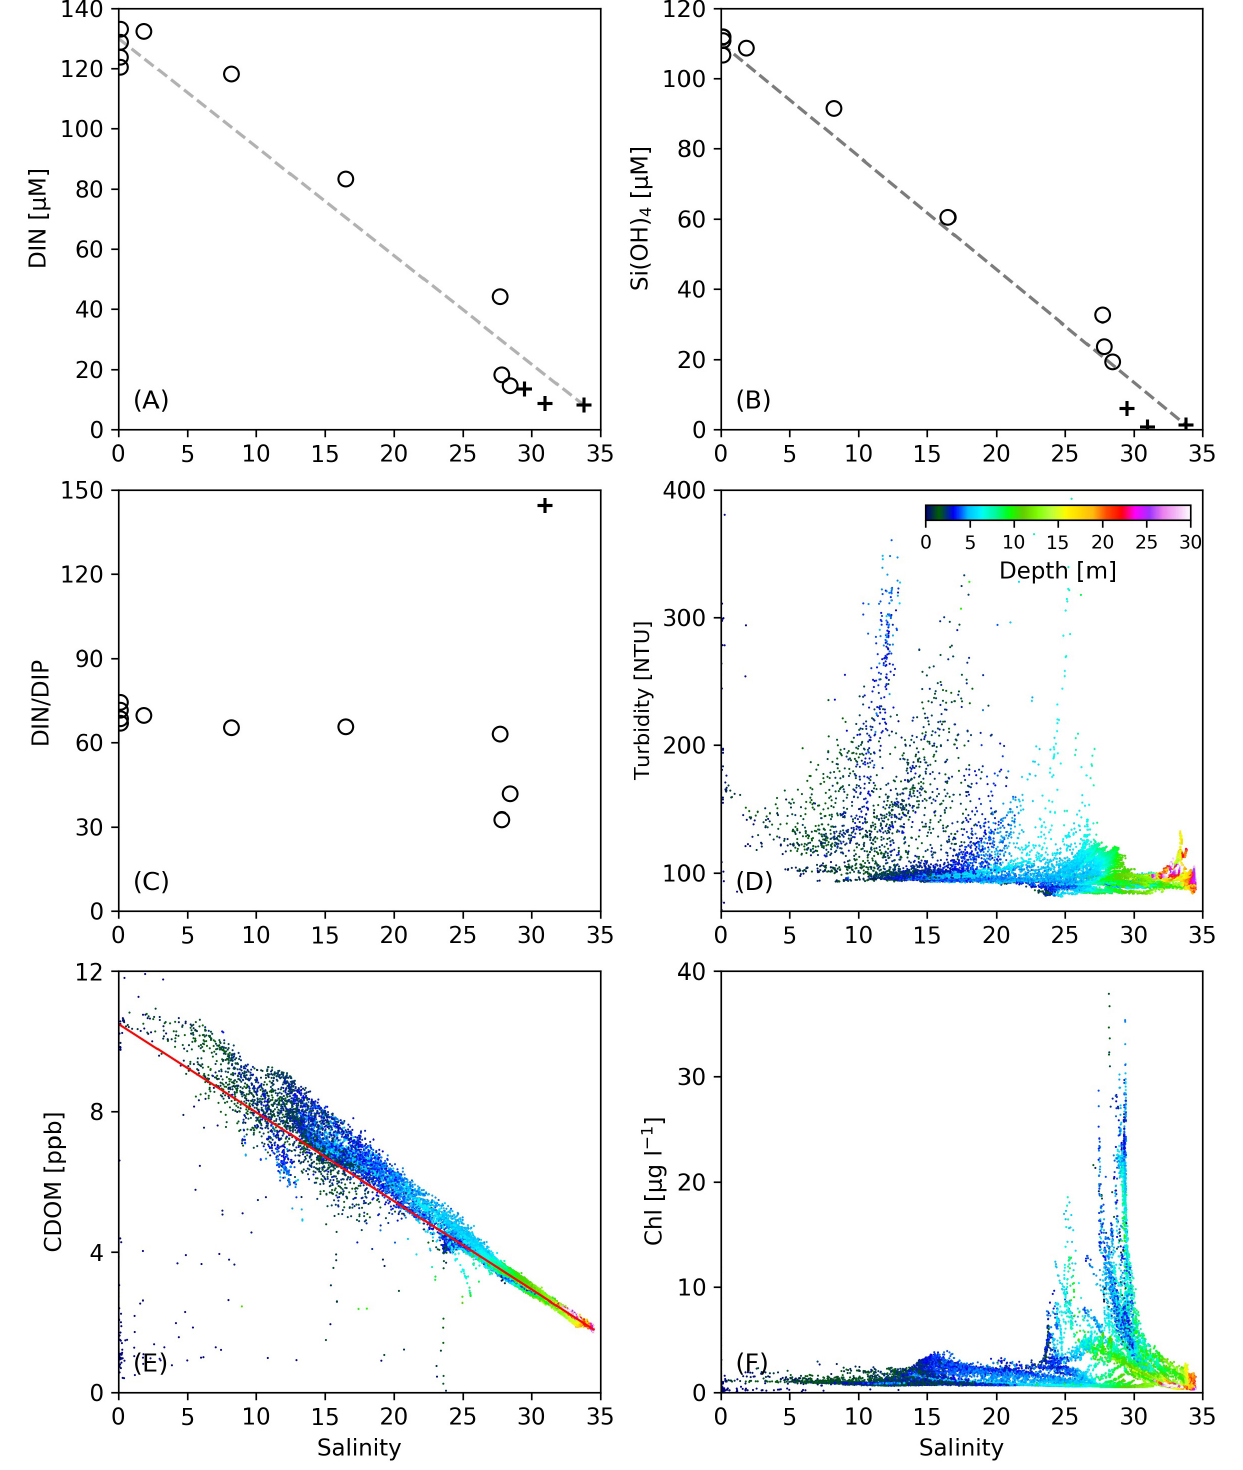
FIGURE 7 | The variations of (A) DIN, (B) Si(OH) 4 , (C) DIN/DIP, (D) turbidity, (E) CDOM, and (F) Chl concentrations as a function of salinity along Transect C1. In (A – C) , open circles denote data from our cruise, and black crosses denote data from the open cruise. Missing black crosses at high salinity in (C) are due to low DIP values under the detection